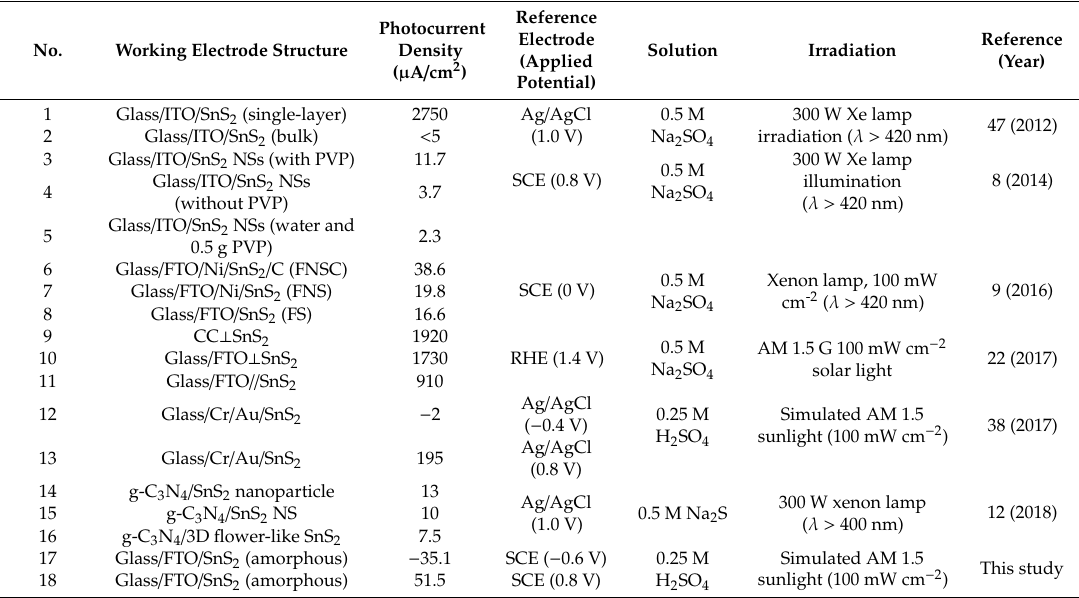
Reference Photocurrent Electrode Density (Applied ( µ A / cm 2 ) Potential)